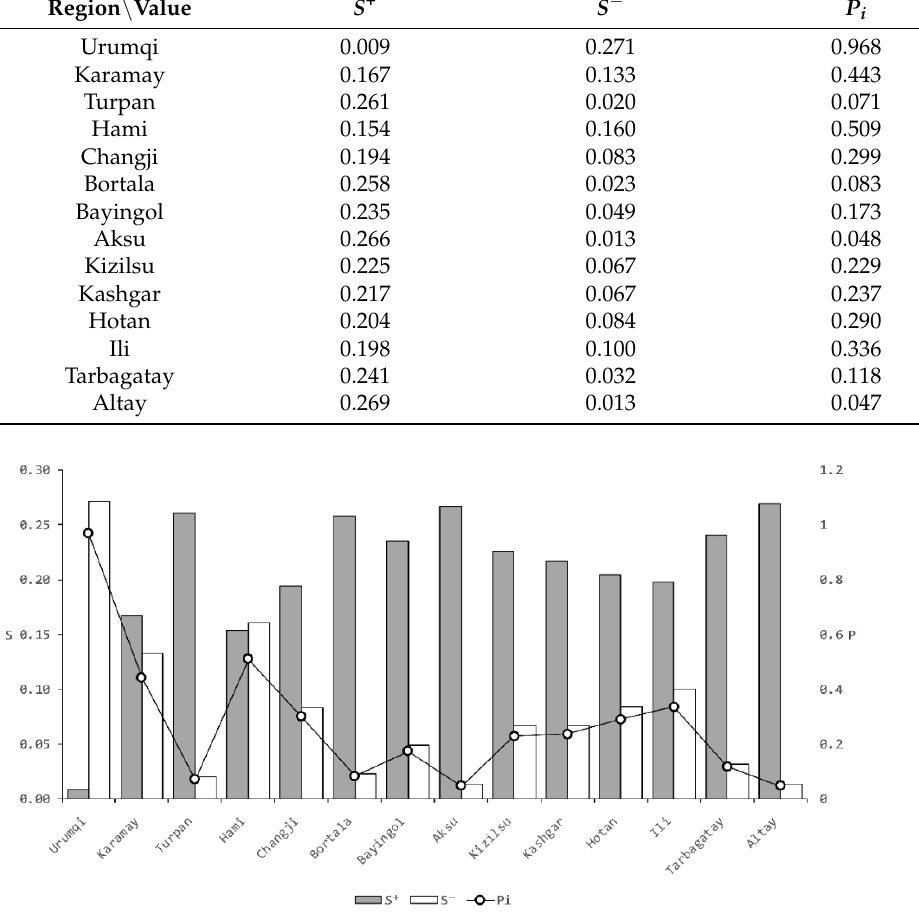
Figure 7. Comparison of 𝑆 + , 𝑆 − and 𝑃 𝑖